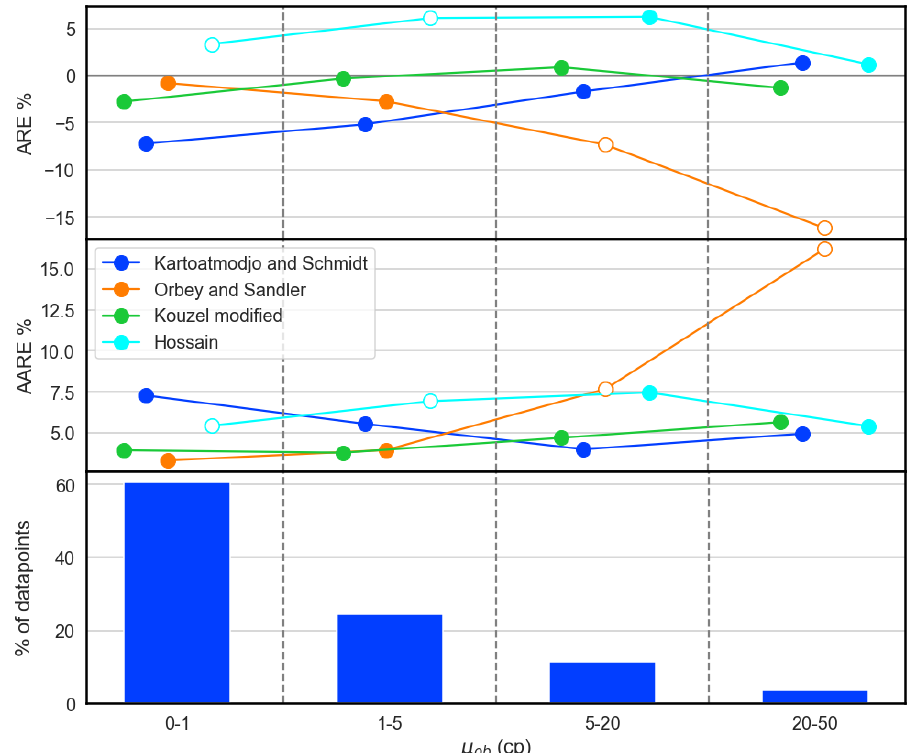
Figure 5. Evaluation of correlations in cluster A 2 (hollow points correspond to results obtained outside the development range of the